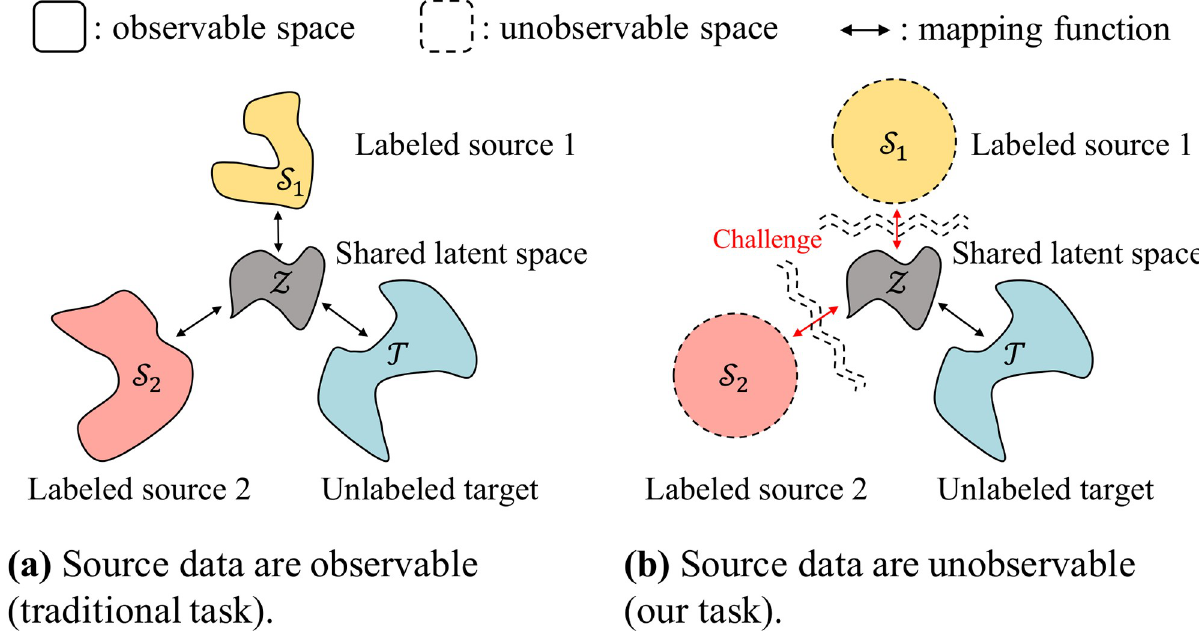
Fig 1. An illustration of unsupervised multi-source domain adaptation (UMDA) problems. (a) illustrates UMDA problem with observable source data, and (b) illustrates data-free UMDA problem with no observable source data. It is challenging to reduce the distribution discrepancy between source and target domains in (b) since there are no accessible source data.